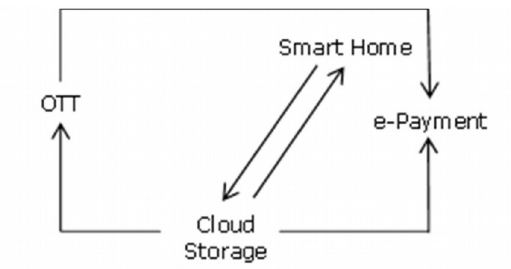
Figure 8. Sample 5 on Smart Home Initiative